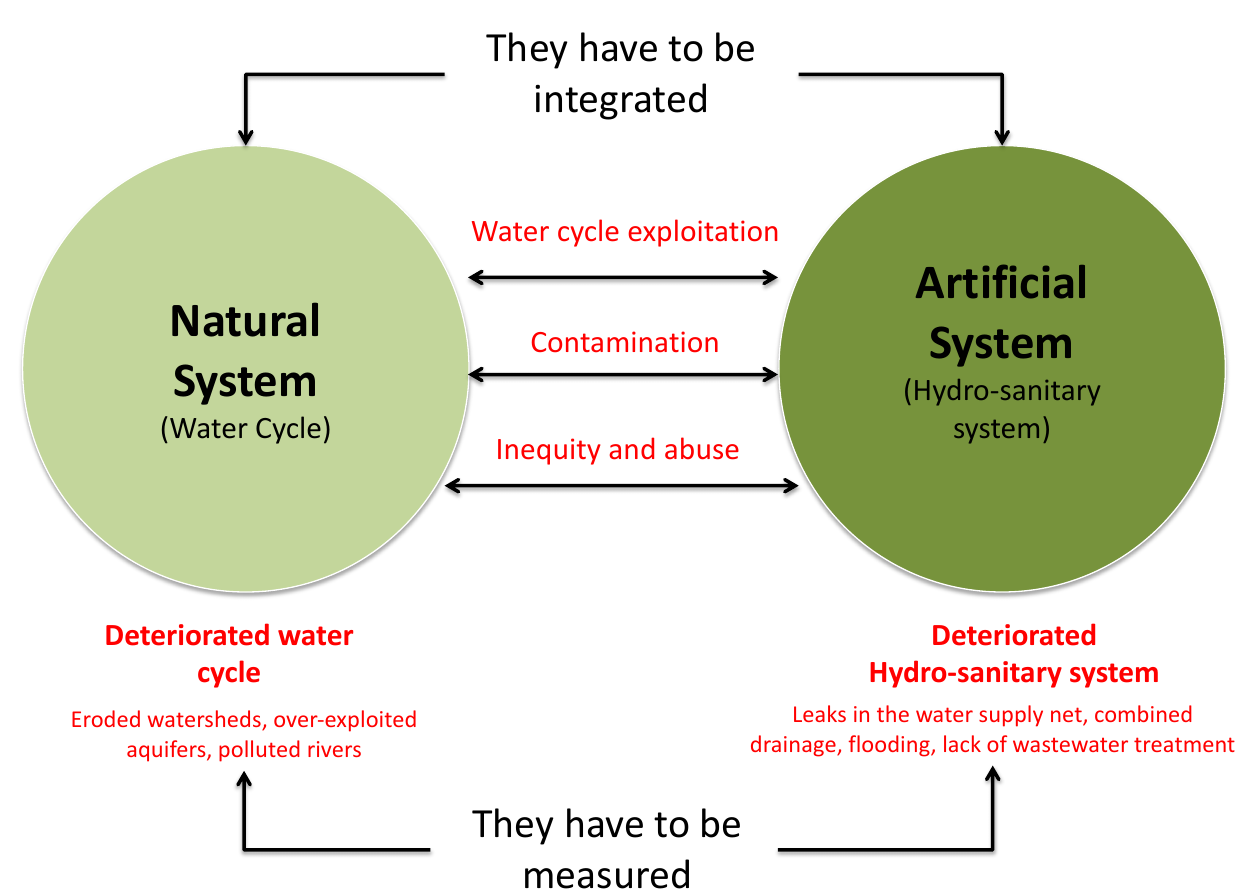
Figure 6. Overview of the results when considering the Water Cycle and the Hidro-sanitary system developed by the SIAPA.